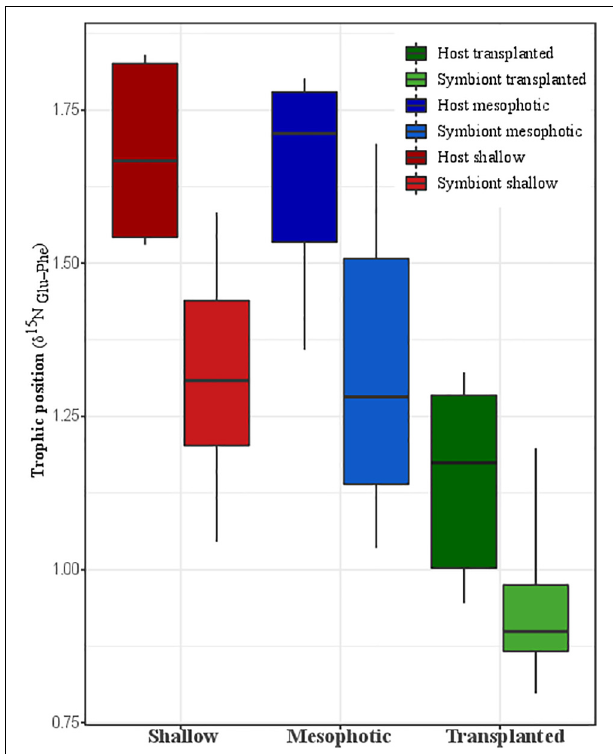
FIGURE 4 | Trophic position calculated trophic position based on nitrogen AA-CSIA of the host and the symbiont from shallow, transplanted, and mesophotic